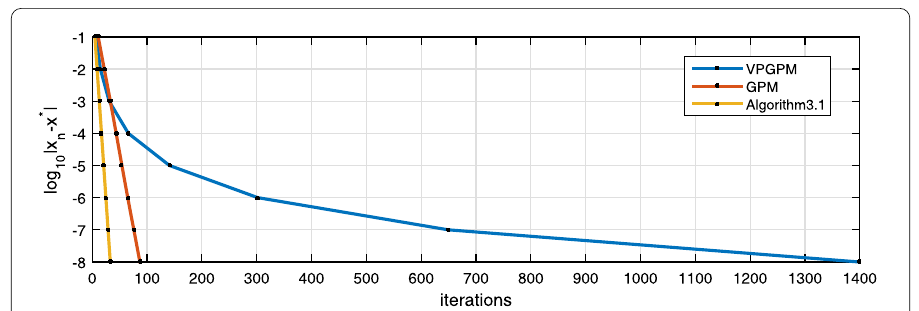
Figure 1 Illustrations and comparison of three algorithms for Example 1